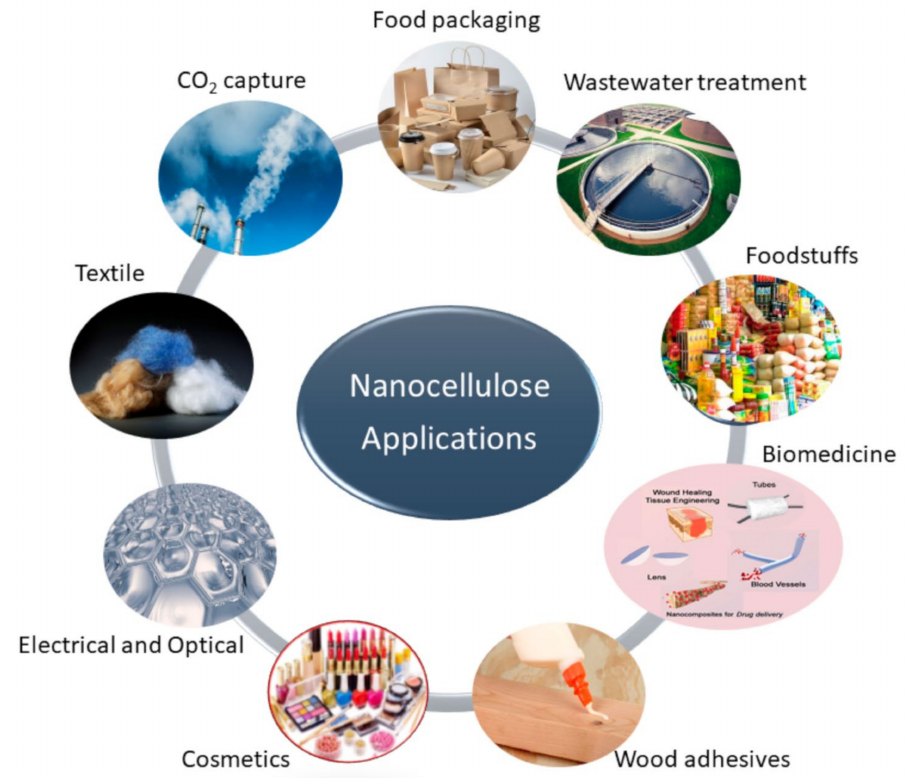
Figure 1. Important applications of nanocellulose [30]. (Open